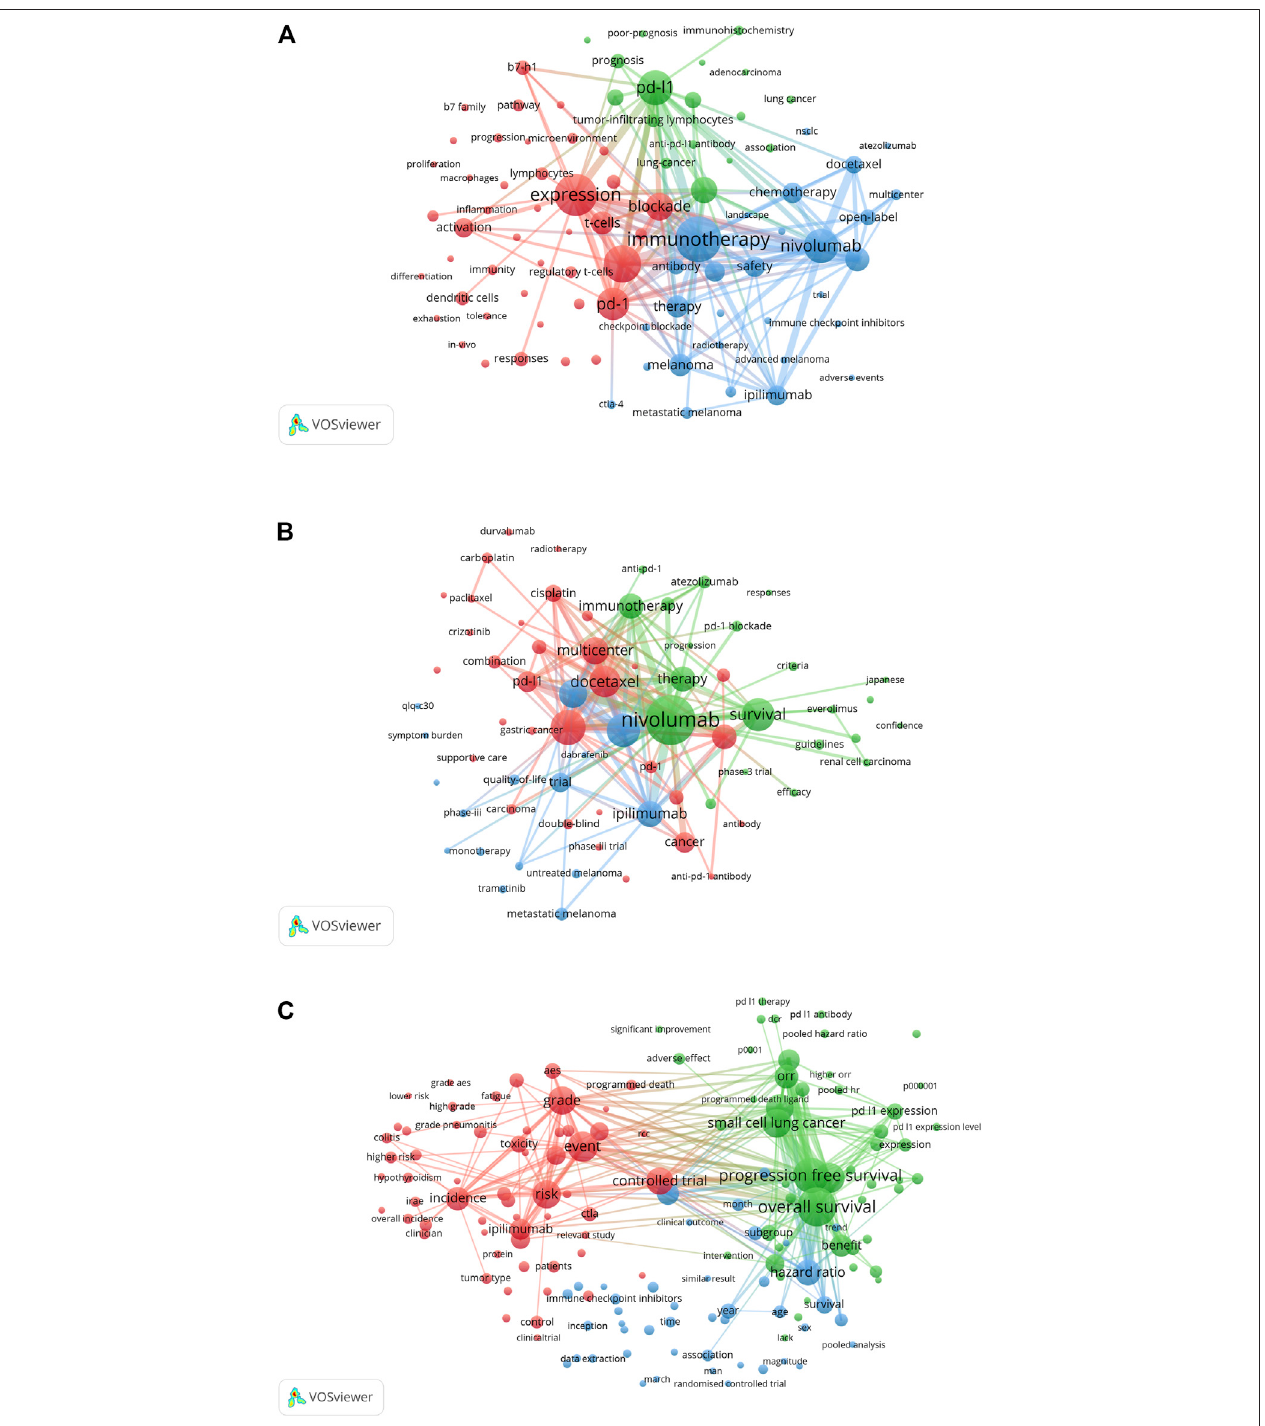
FIGURE 3 | VOSviewer network visualization map of keyword and term co-occurrence analyses. The cluster analysis of keyword co-occurrence in the articles on the PD1/PDL1 molecule (A) and RCT of anti-PD1/PDL1 (B) . (C) The cluster analysis of term co-occurrence in meta-analysis of anti-PD1/PDL1.